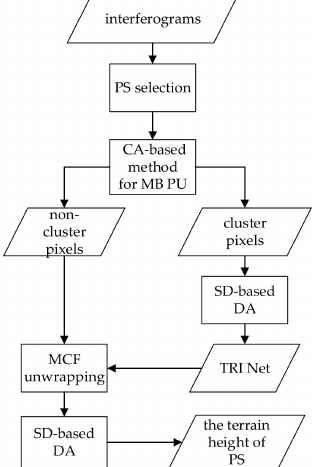
Figure 3. Processing flow of the improved